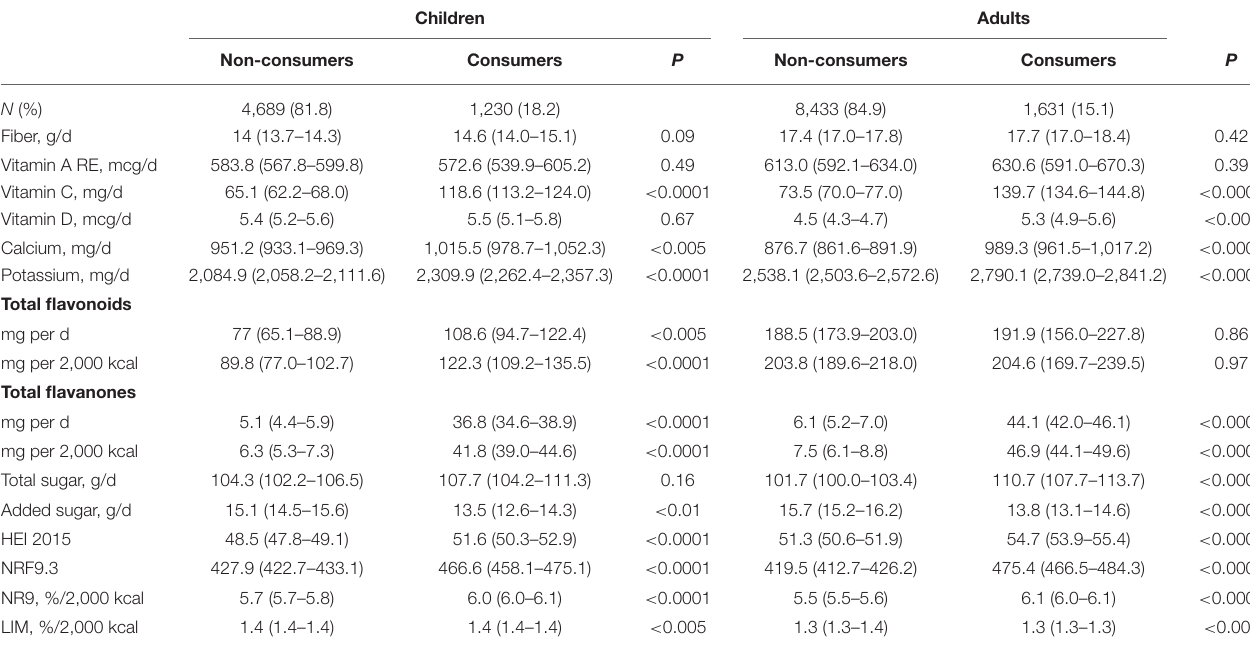
TABLE 4 | Diet quality indicators for consumers and non-consumers of